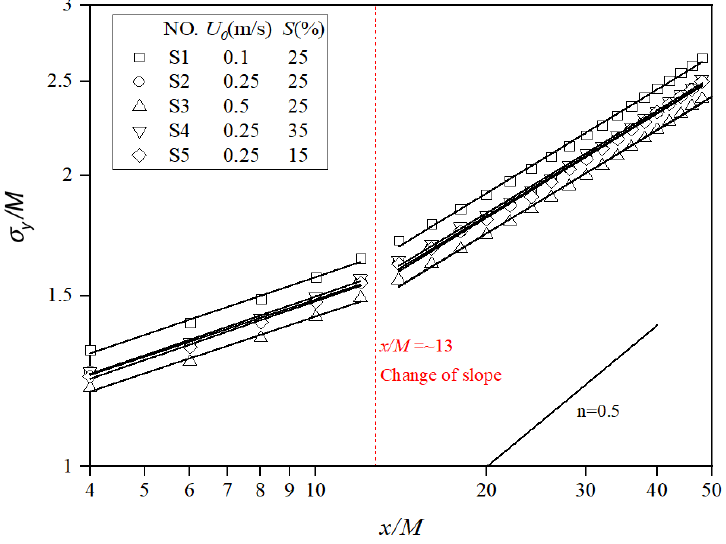
Figure 9. Evolution of the plume spreading width 𝜎 𝑦 with downstream distance.